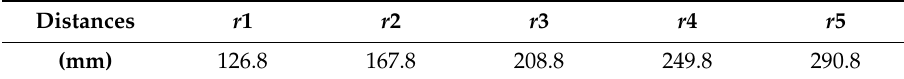
Table 4. Distances of sensors S1–S5 to the center of the cylinder tank used to hold the geothermal experimental device.